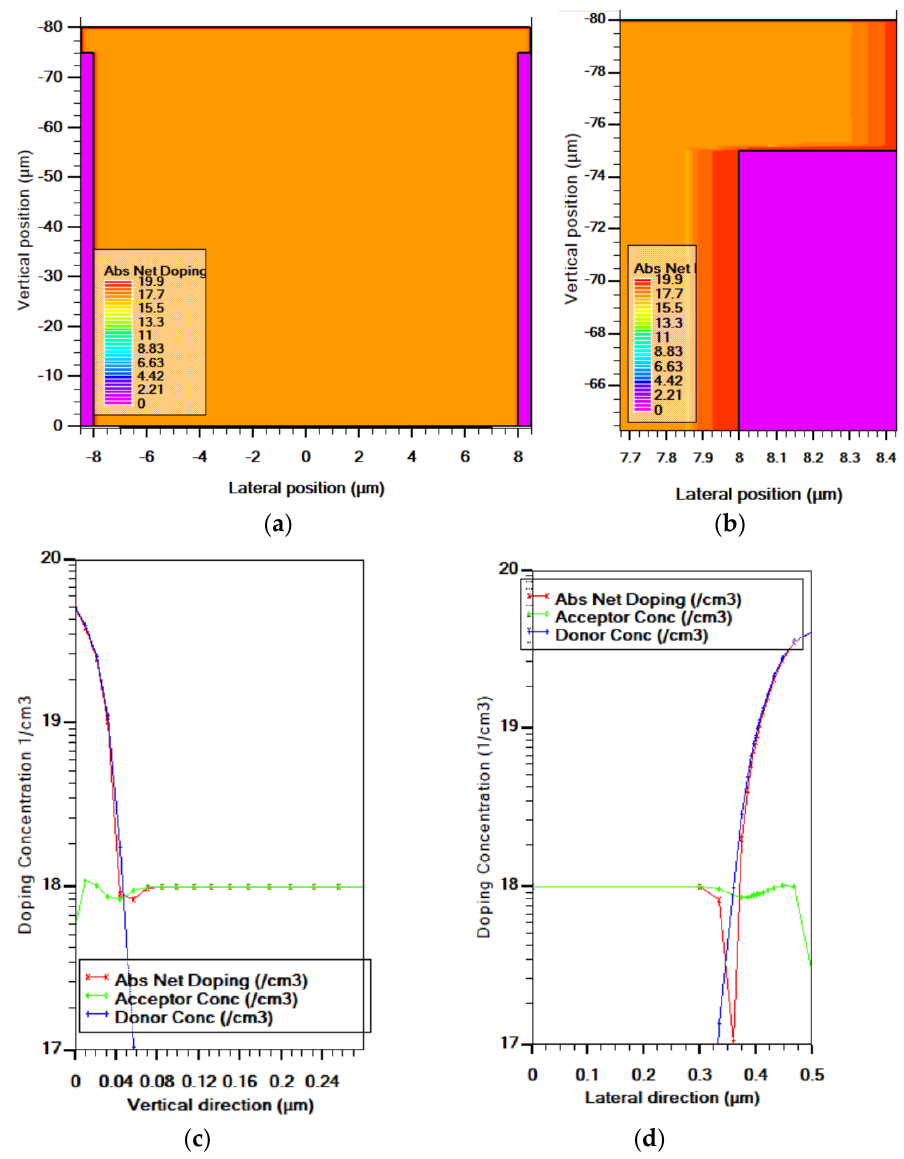
Figure 2. The flipped structure using SILVACO Athena process simulator: ( a ) cross-sectional view for the whole cell showing the absolute net doping contours in cm − 3 , ( b ) a close view near the emitter region, ( c ) vertical cutline (perpendicular to the upper surface) showing the doping profile of the vertical pn junction and ( d ) lateral cutline showing the doping profile of right lateral pn junction.